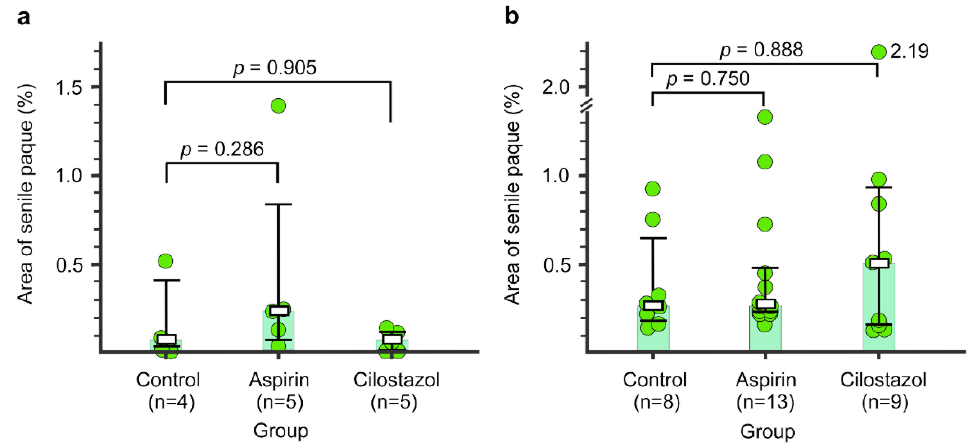
Figure 7. The percent area of senile plaque in the control, aspirin, and cilostazol groups evaluated at 15 months ( a ) and 21–23 months ( b ). Light-green-colored bar graphs indicate median. Boxes and bars indicate median and interquartile range, respectively. Green circles represent the value of percent area of senile plaque of each mouse. The numbers next to the green circle (2.19) indicate percent area of senile plaque out of the range of the vertical axis scale (b, Cilostazol group).